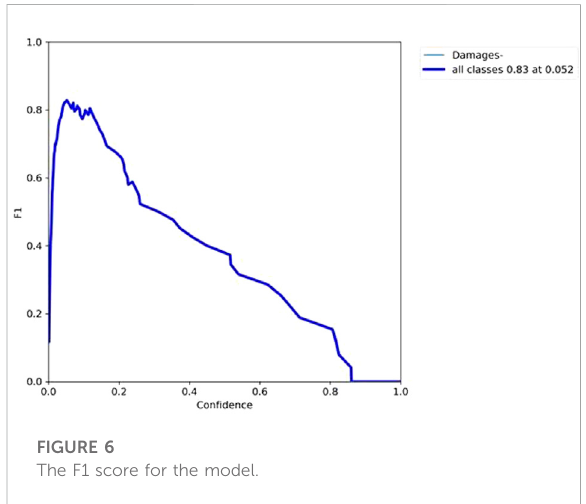
FIGURE 6 The F1 score for the